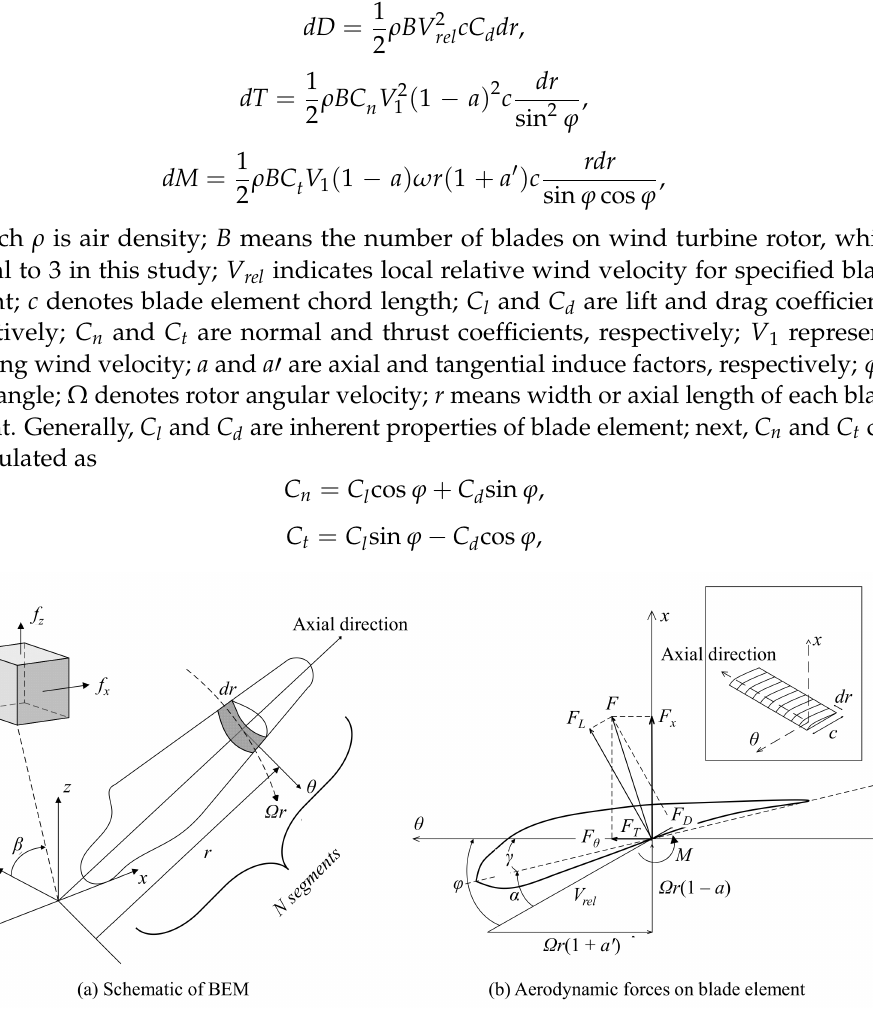
Figure 1. ( a ) Schematic of BEM; ( b ) aerodynamic forces on blade